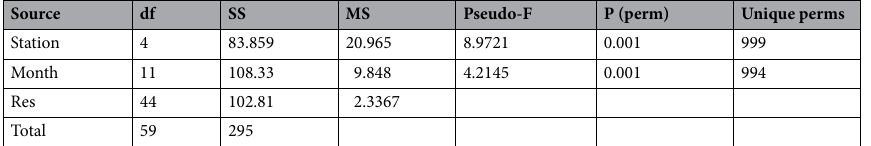
Table 1. Spatial and temporal patterns of the environmental factors based on Euclidean distances assessed using repeated-measure permutational analysis of variance (PERMANOVA) with the sampling months as fixed factor and the stations as random factor.